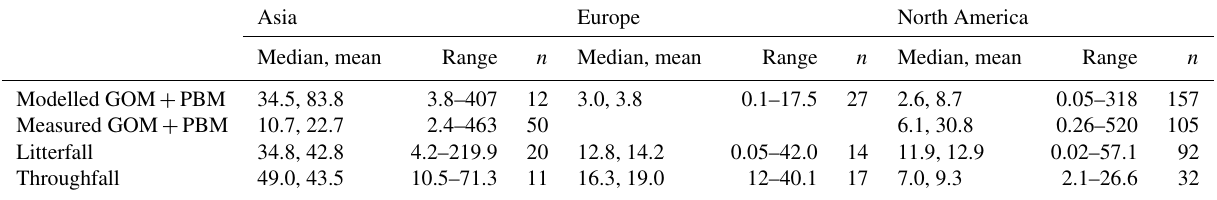
Table 1. Summary of estimated and measured mercury dry deposition and measured mercury in litterfall and throughfall in Asia, Europe, and North America (converted to annual value in the unit of µgm − 2 yr − 1 )